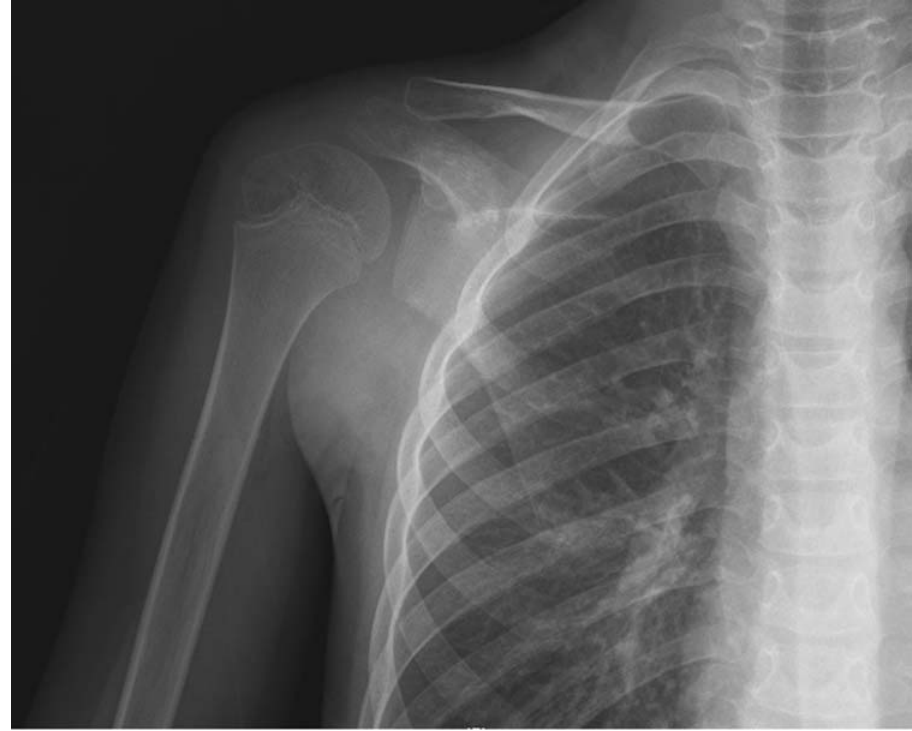
Fig. 1 Anteroposterior (AP) X-ray of the right shoulder at initial presentation demonstrating no obvious deformity, dislocation, or malignancy.